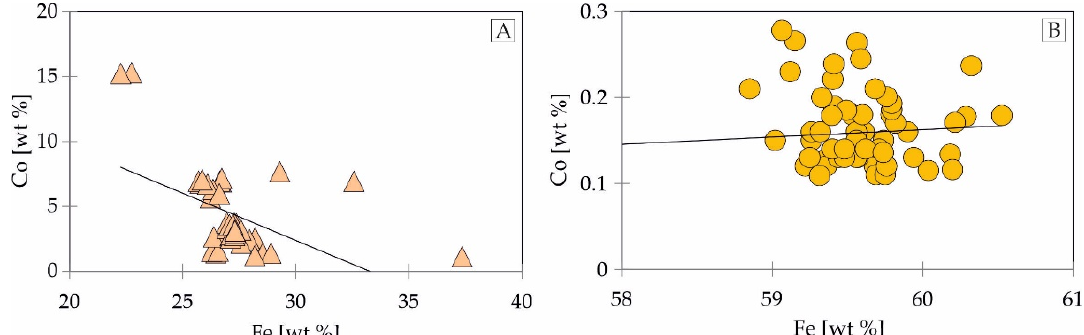
Figure 13. Bivariate diagrams of trace elements in sulphides from the magnetite-ilmenite ores in the Udryn and Krzemianka Fe-Ti-V deposits. ( A ) Fe vs. Co in pentlandite; ( B ) Fe vs. Co in pyrrhotite. Table 5. Pearson’s correlation coefficients of selected elements for the sulphides from magnet- ite-ilmenite ores in the Fe-Ti-V deposits in Poland. Mineral